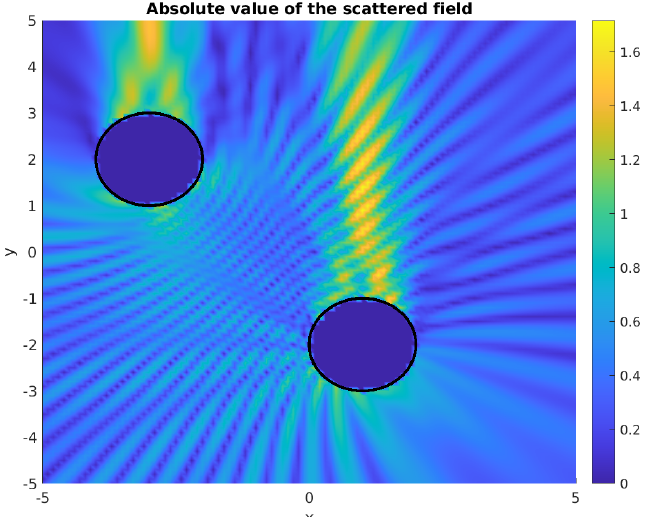
Figure 2. Absolute value of the scattered wave in a simulation with given obstacles. An upward planar incident wave was applied with k = 4 π